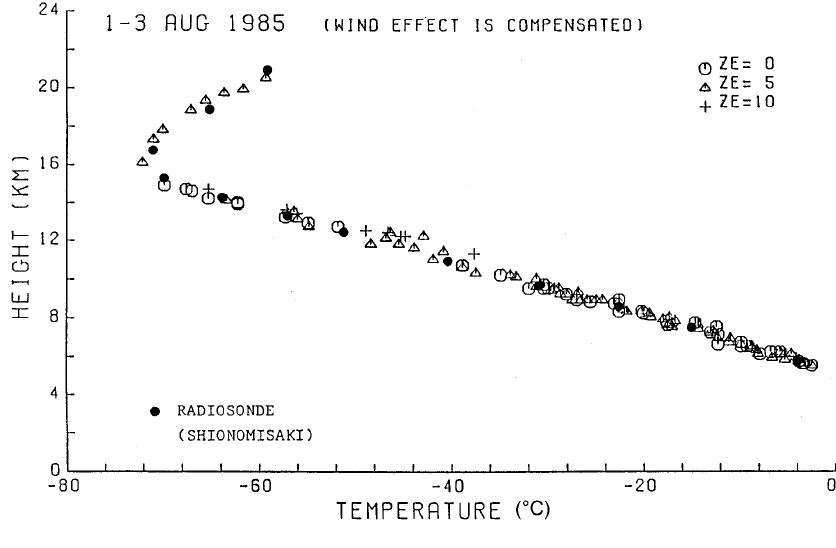
Fig. 11. Temperature profiles on 1–3 August, 1985, measured by the MU radar with RASS with three di(cid:128)erent radar zenith angles, compared with the mean temperature from routine Japan Meteorological Agency radiosonde ascents from Shionomisaki, ~ 157 km to the south (from Matuura et al